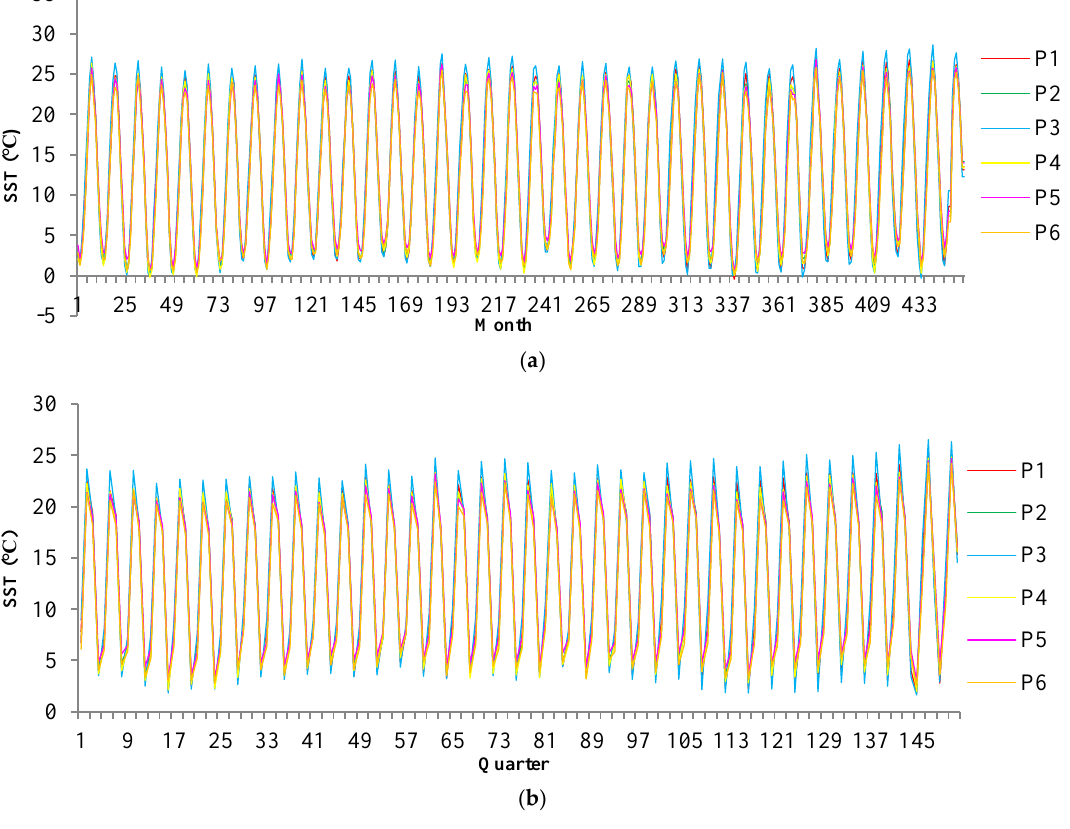
Figure 4. Monthly and quarterly data used in this paper. ( a ) Monthly data used in this paper. ( b ) Quarterly data used in this paper.